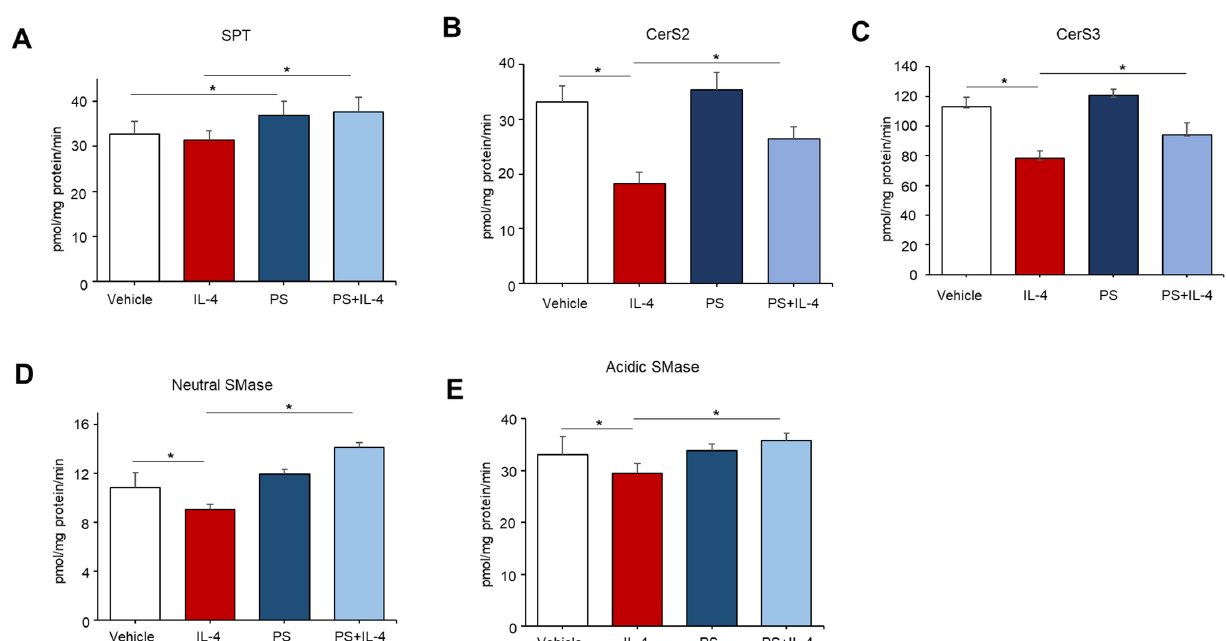
Figure 3. N-palmitoyl serinol (PS)-mediated alteration in activities of key enzymes responsible for ceramide synthesis. HaCaT KC were pretreated with IL-4 (50 ng/mL) for 20 h, followed by incubation with exogenous PS (25 µ M) for 4 h. Serine palmitoyltransferase (SPT) ( A ), ceramide synthase (CerS) 2 ( B ), CerS3 ( C ), neutral sphingomyelinase (SMase) ( D ), or acidic sphingomyelinase (SMase) ( E ) were measured by the LC-MS/MS system. Statistical significance was calculated using the unpaired Student’s t -test, and significance was defined as * p < 0.01 vs. vehicle control (or untreated control).